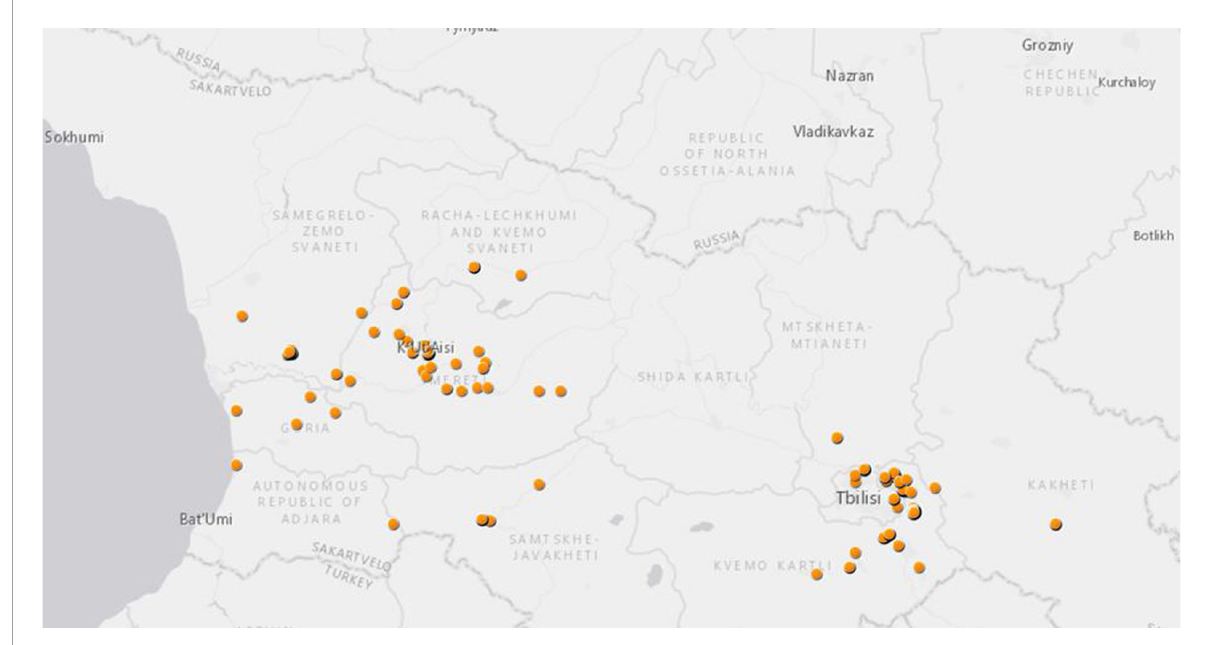
FIGURE1 Mosquito collection in Georgia from 2018 to 2019 for this study. Each dot represents GPS coordinates of each mosquito collection site.